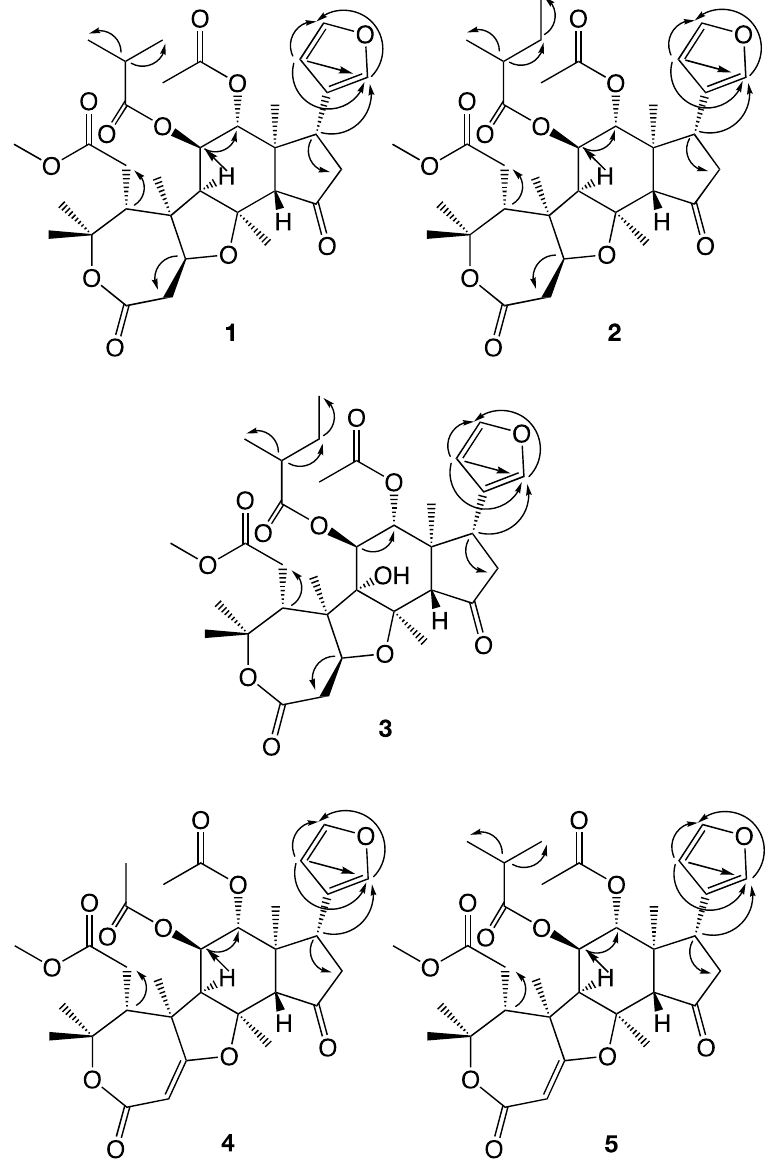
Figure 3. COSY correlations observed with compounds 1 – 5.